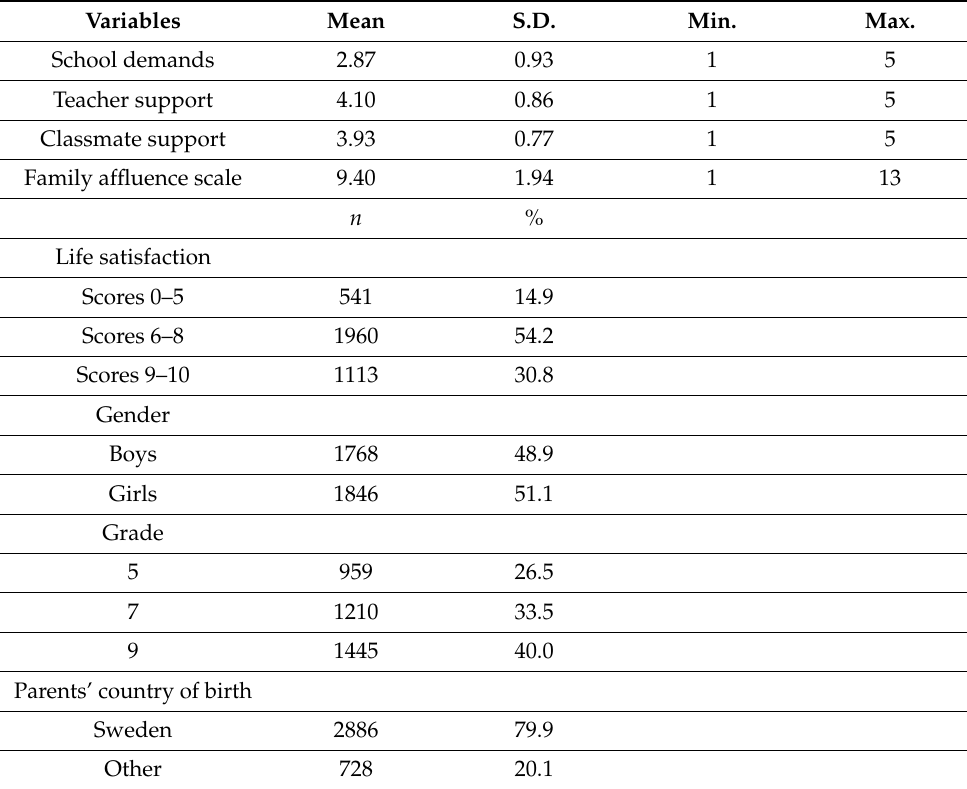
Table 1. Descriptive statistics ( n =